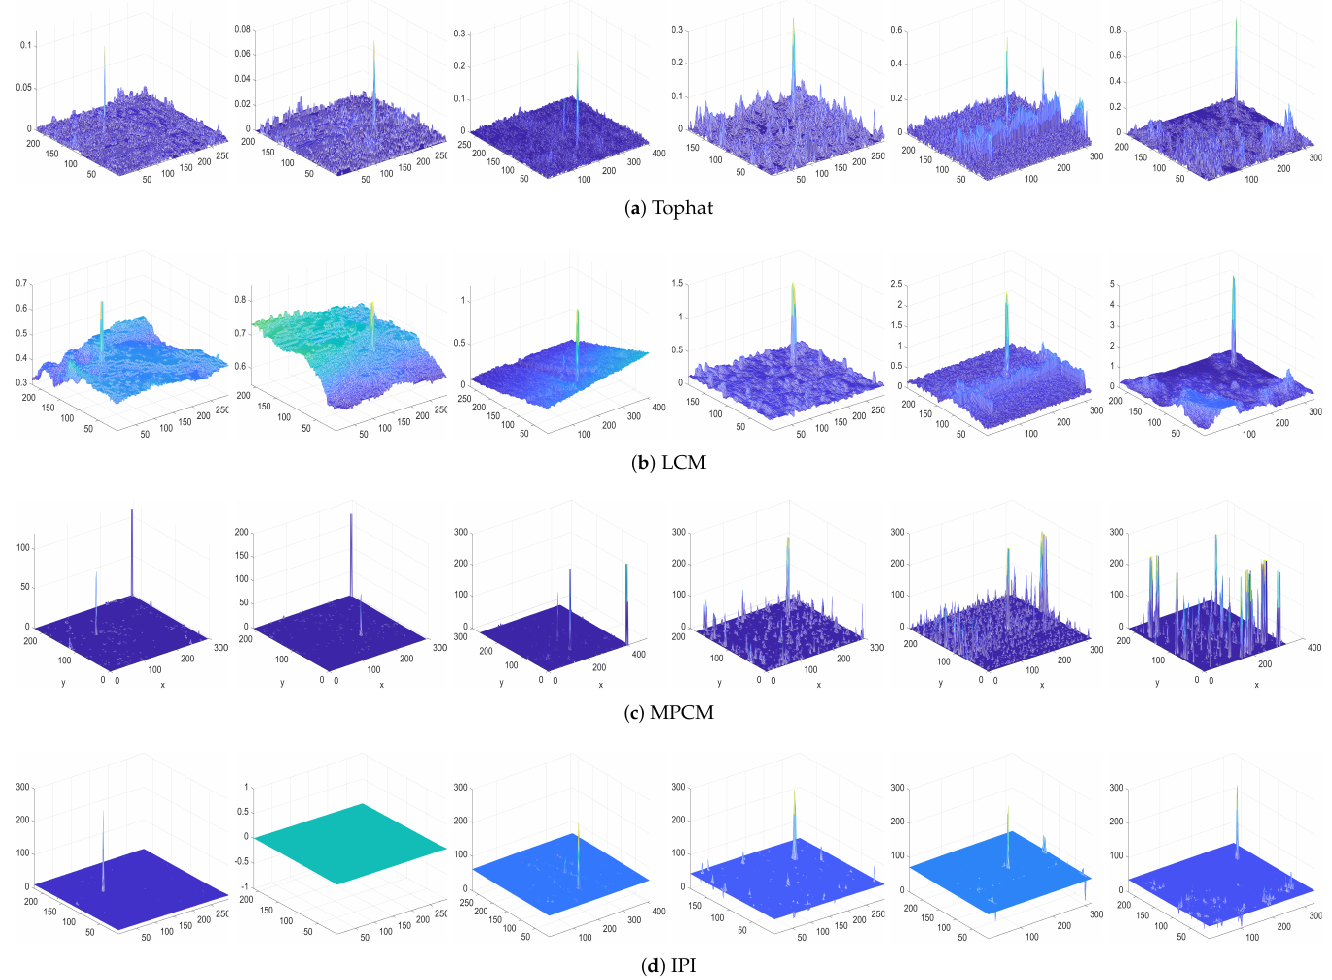
Figure 10. From left to right are the 3D gray images of the detection results of the 1 ∼ 6 sequences of